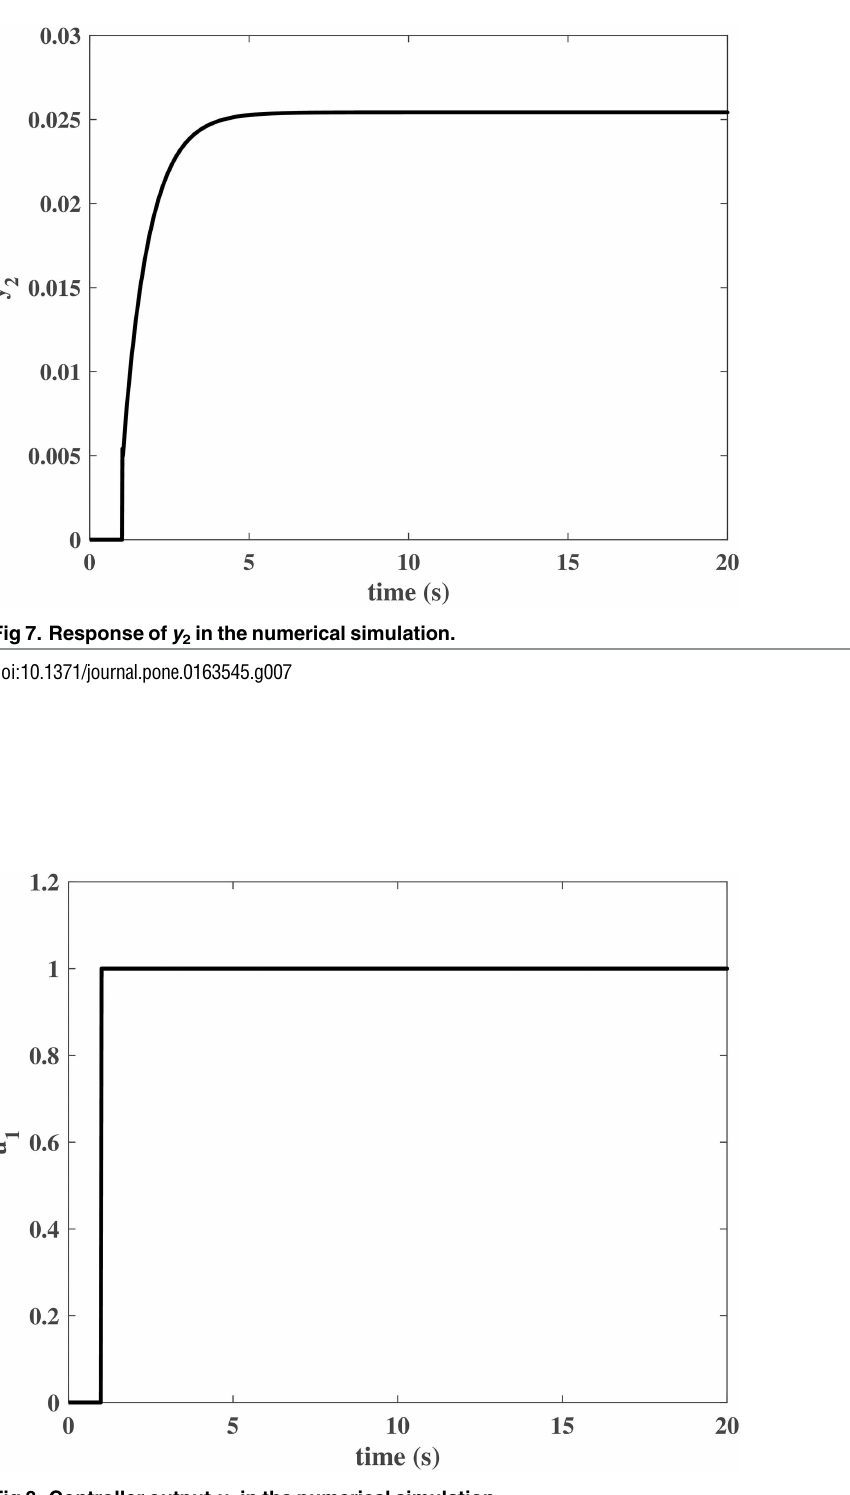
Fig 8. Controller output u 1 in the numerical